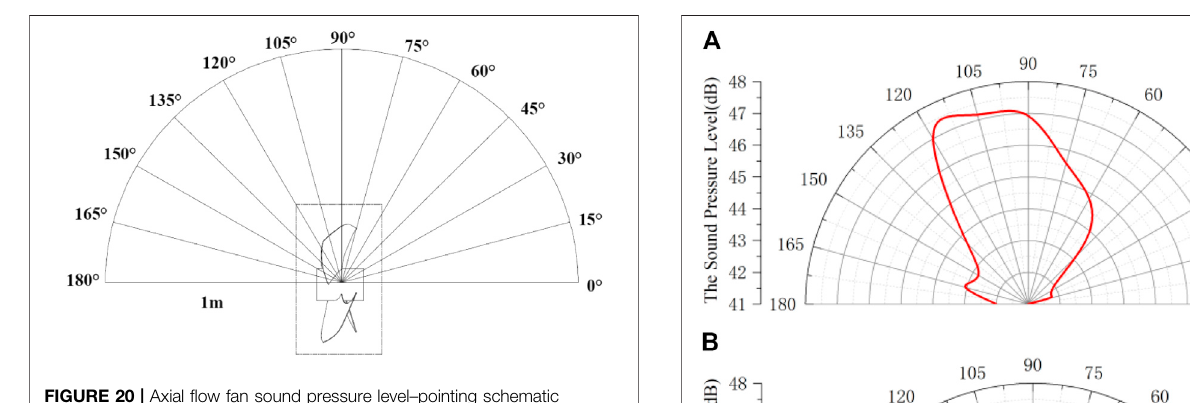
FIGURE 20 | Axial fl ow fan sound pressure level – pointing schematic